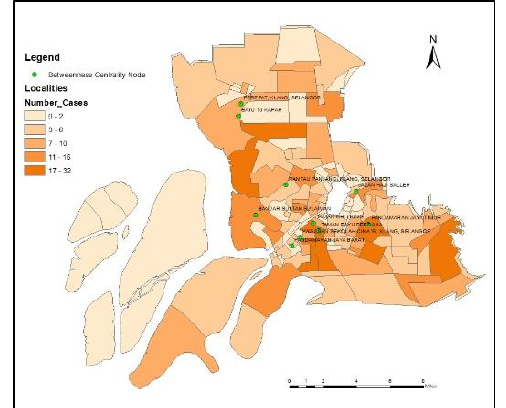
Figure 15. The relationship of betweenness centrality node and TB hotspot